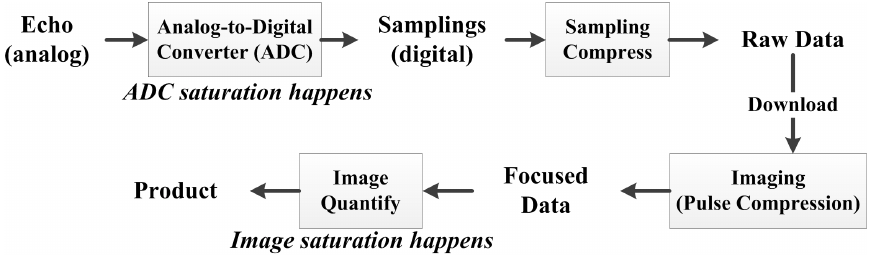
Figure 1. Data flow of the synthetic aperture radar (SAR) system.